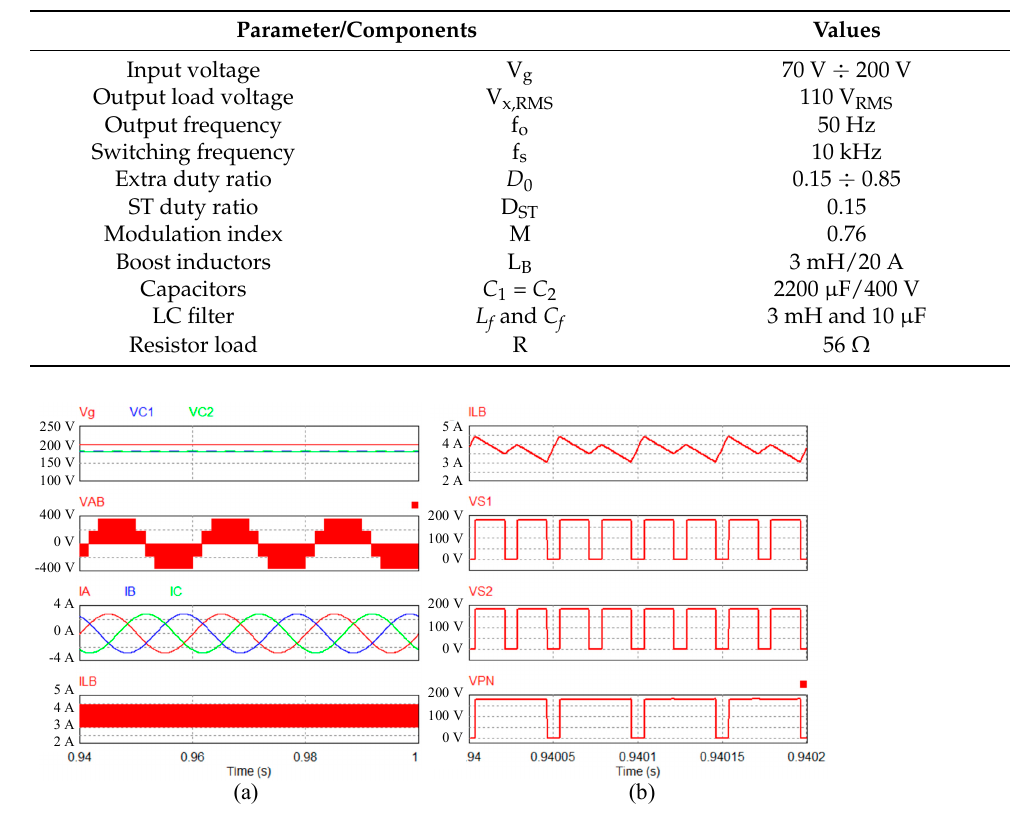
Figure 8. The simulation results of the proposed method when V g = 200 V. From top to bottom: ( a ) input voltage ( V g ), capacitor voltage ( V C 1 , V C 2 ), line-to-line voltage ( V AB ), load current ( I A , I B , I C ), inductor current ( I LB ), ( b ) zoom in of inductor current ( I LB ), impedance switch voltages ( V S1 , V S2 ), DC-link voltage ( V PN ).